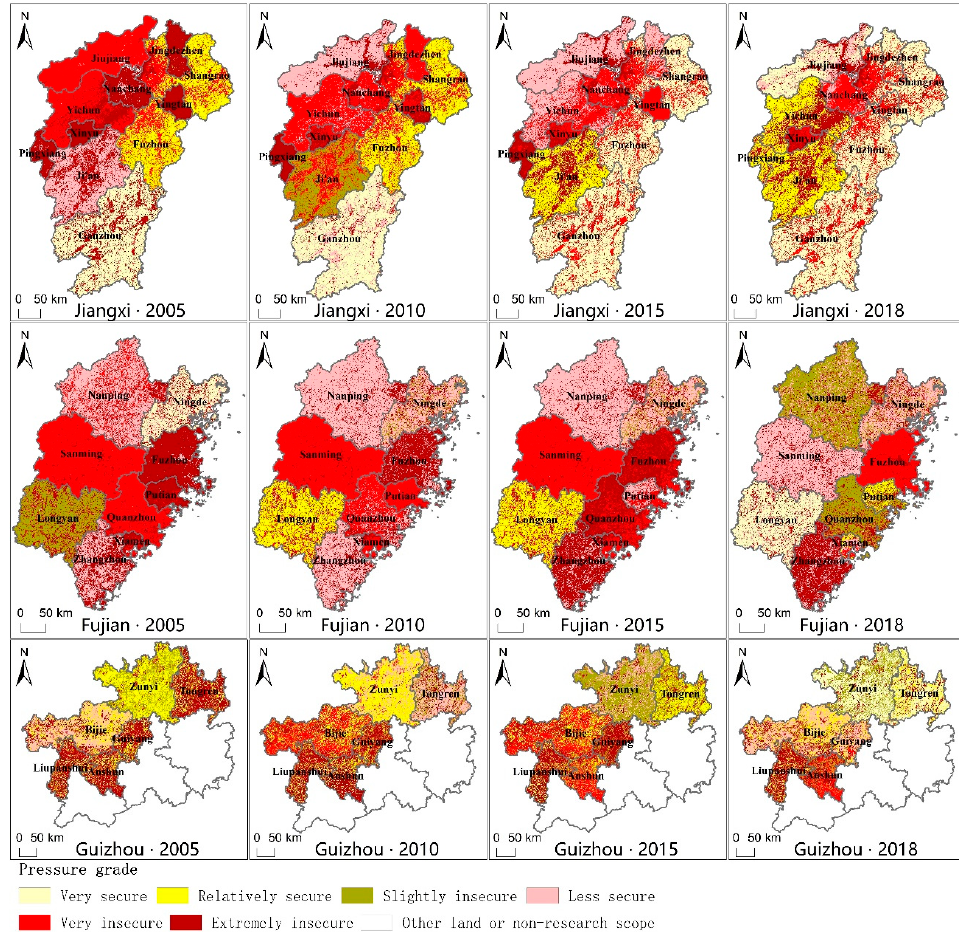
Figure 5. Spatial pattern of ecological security.